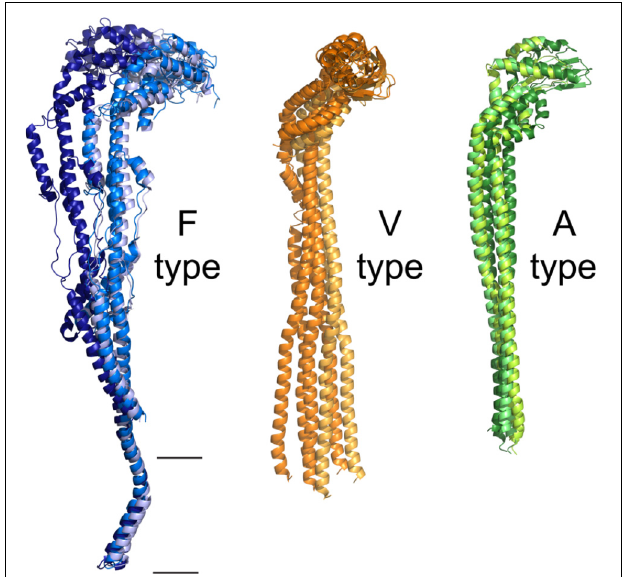
FIGURE 7 | Flexibility of the peripheral stalk of rotary ATPases. Flexibility of the peripheral stalk illustrated with the transitions it goes through during the process of rotational catalysis. (A) Models that correspond to the transitions of an F-ATPase peripheral stalk; PDBs 5ARI, 5ARA, 5FIL from Zhou et al. (2015). The membrane section in these models is not accurately represented due to the resolution of the maps. Higher resolution maps have been obtained but only in one rotational state and thus are not useful to illustrate the flexibility of the peripheral stalk. (B) Models that correspond to three rotational states of one of the peripheral stalks of the V-ATPase of S. cerevisiae ; PDBs 3J9T, 3J9U, 3J9V from Zhao et al. (2015). (C) Models that correspond to three rotational states of one of the peripheral stalks of the A-ATPase of T. thermophilus ; PDBs 5Y5X, 5Y5Z, 5Y60 from Nakanishi et al. (2018). The black horizontal lines indicate the mitochondrial inner